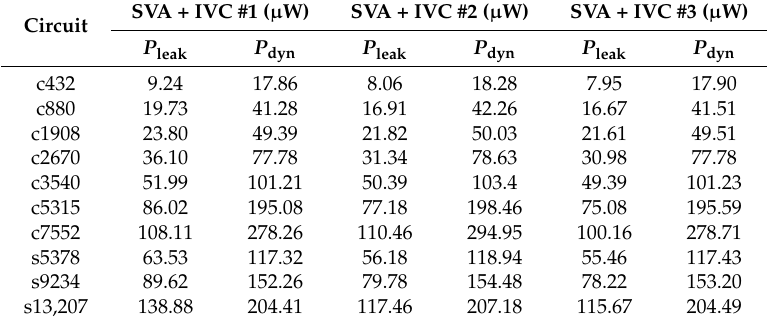
Table 5. Leakage and dynamic power of SVA combined with different ILP formulations ( R AS = 0.1). Circuit